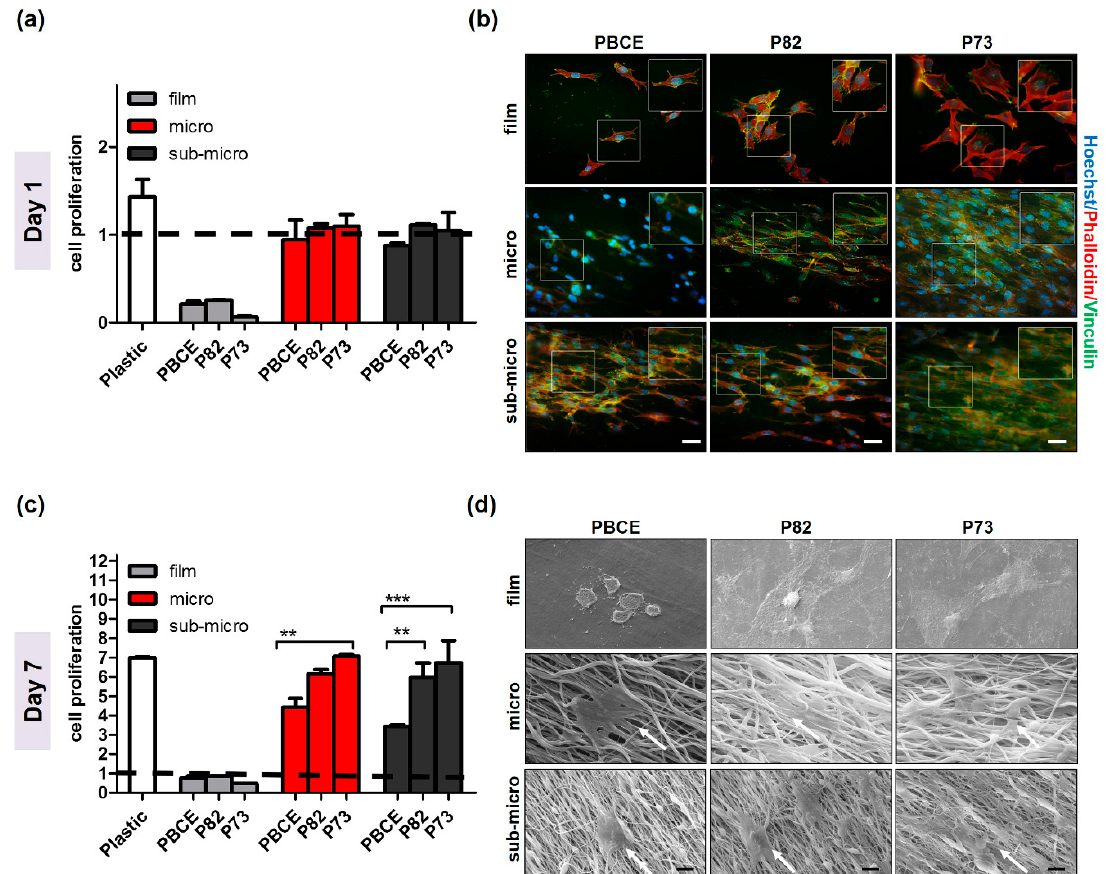
Figure 3. C2C12 proliferation and morphology on microfibrous and sub-microfibrous PBCE and P(BCE- co -TECE) scaffolds. ( a , c ) Cell growth evaluation was performed using the CCK8 assay at day 1 ( a ) and 7 ( c ) of culture. Cell proliferation (fold increase) is plotted as the ratio between number of cells at each time and number of cells seeded (1.0 × 10 5 cells/scaffold) on day 0 (indicated by dashed line); ** p < 0.01; *** p < 0.001. ( b ) Expression of focal adhesion protein vinculin (green). The cytoskeleton organisation was observed by F-actin staining with Phalloydin (red). Nuclei were stained with Hoechst 33342 (blue). Magnified areas of cells are shown in insets. Scale bars = 50 µ m. ( d ) Representative scanning electron microscopic images of the cells cultured on PBCE, P82, and P73 materials. Scale bars: 10 µ m. White arrows are positioned to indicate C2C12 cells.